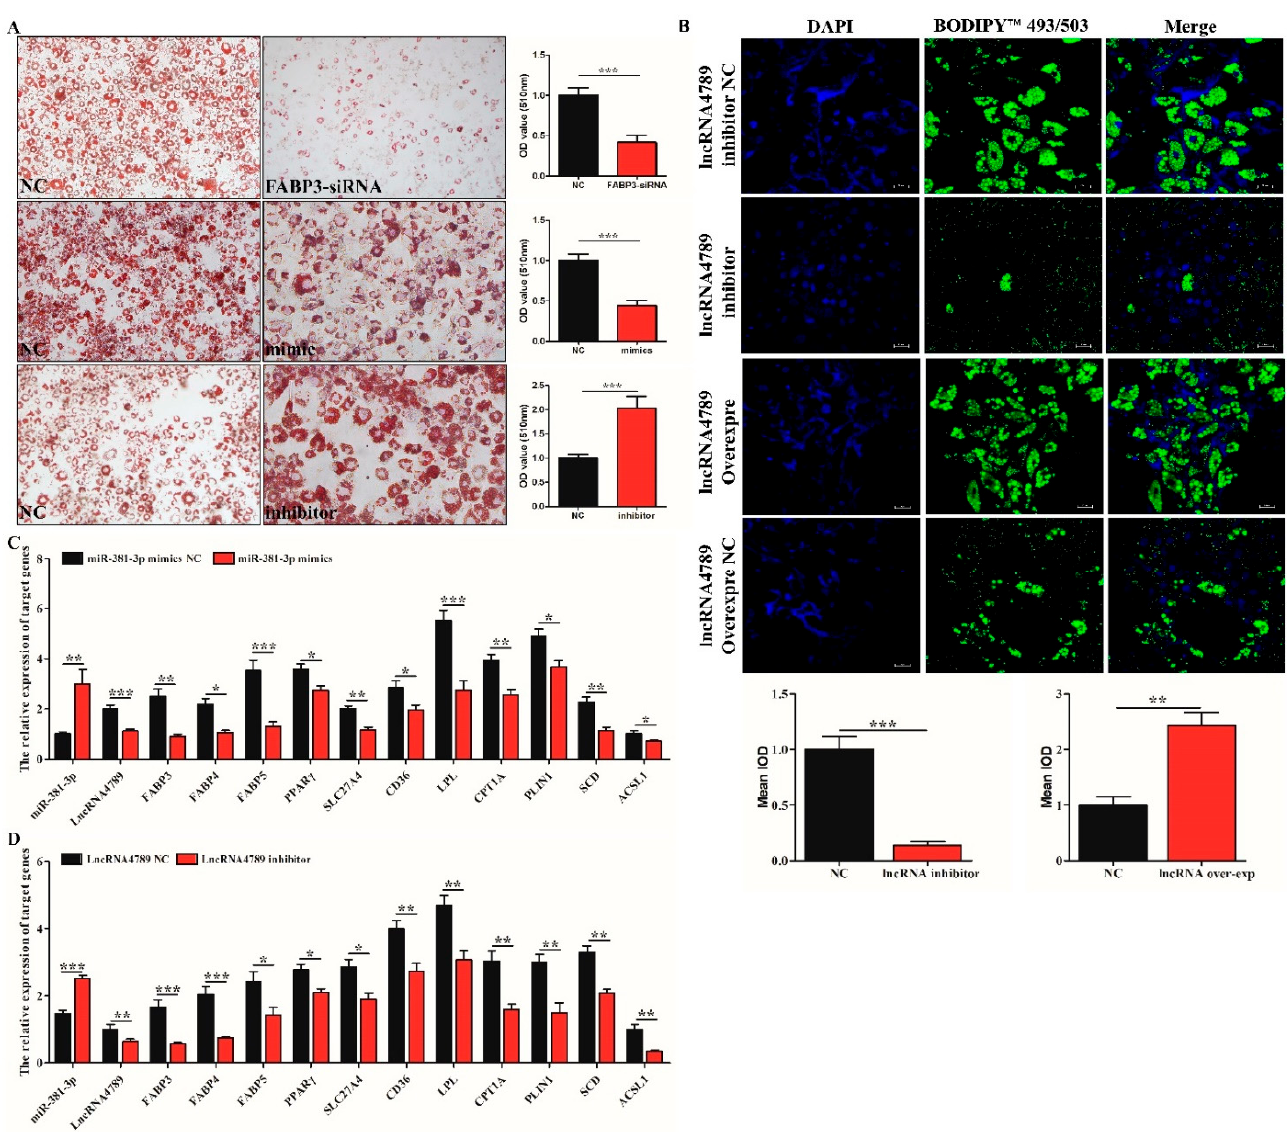
Figure 6. FABP3 regulated adipogenic differentiation by PPAR signalling pathway. ( A ) ORO staining and quantification between NC and FABP3 -siRNA (top), miR-381-3p mimics (middle) and inhibitor (bottom); ( B ) fluorescence staining of lipid droplet following transfection of lncRNA4789 overexpression, lncRNA4789 inhibitor, lncRNA4789 overexpression NC and lncRNA4789 inhibitor NC; cell nuclei were stained with DAPI (blue) while lipid droplets were stained green with BODIPY™ 493/503; ( C ) mRNA expression of related genes involved in the PPAR signalling pathway, following miR-381-3p overexpression; ( D ) mRNA expression of related genes involved in the PPAR signalling pathway following transfection with an lncRNA4789 inhibitor; * p < 0.05, ** p < 0.01, *** p <